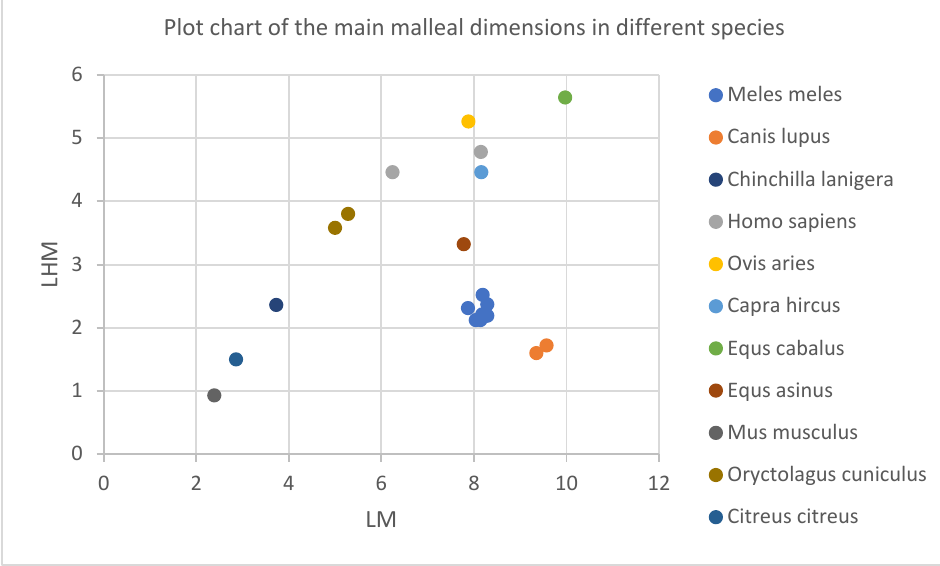
Figure 6. Graphical representation of the malleal ratios for different species.